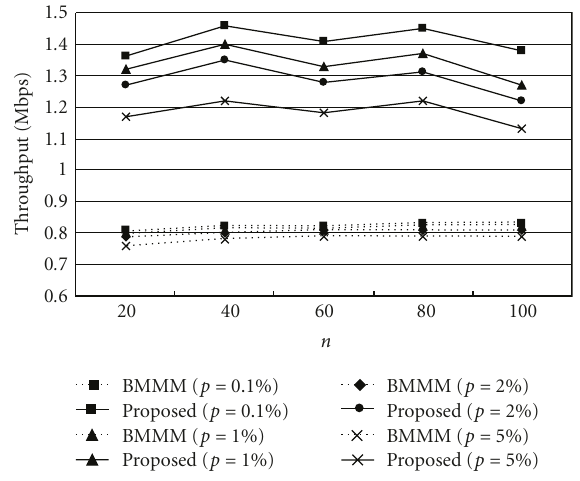
Figure 1: Throughput results with multicast and uplink user payloads of 88